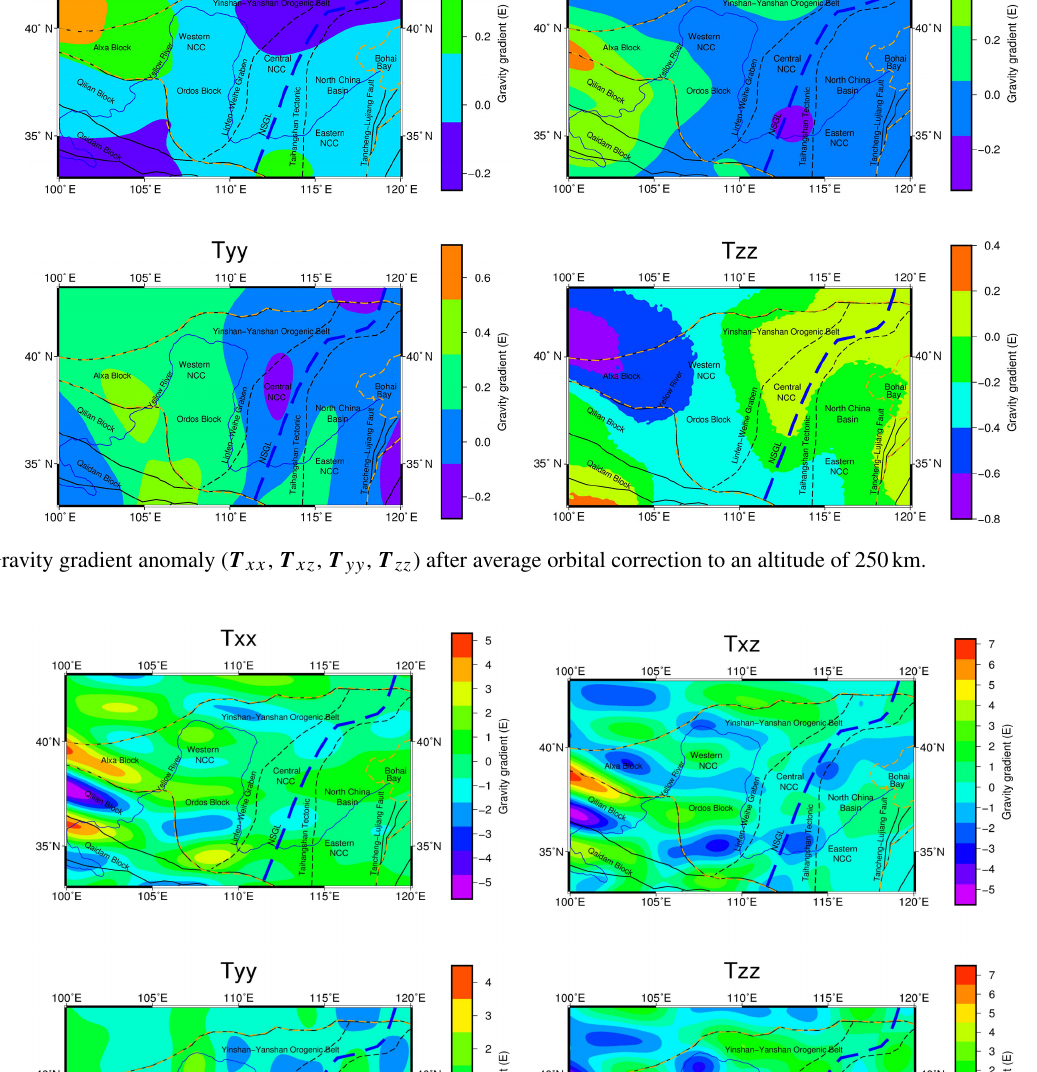
The average depth is calculated from the depth data of the sediment in NCC (Fig. 10a) provided by CRUST 1.0 with a spatial resolution of 1 ◦ × 1 ◦ (Laske et al., 2013); then, the interface undulation data of the sedimentary layer (Fig. 10b) are obtained after correcting for the average sedimentary layer depth. With respect to the calculated average depth,